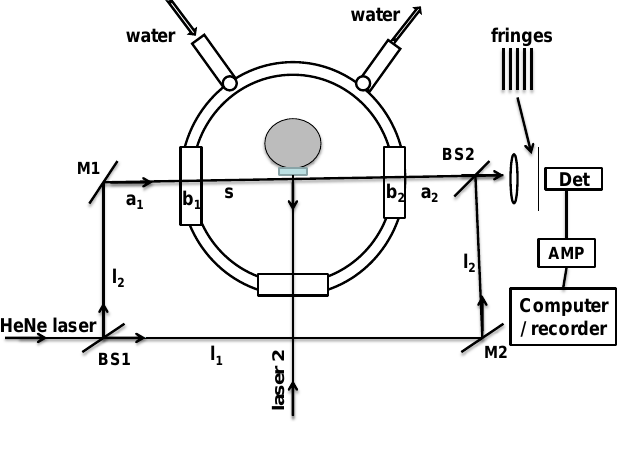
Figure 15. Optical configuration of the Mach-Zehnder interferometer configuration for the measurement of changes in solution concentration/index of refraction. Measurement beam passes in front of the seed crystal inside the solution. Laser 2 is used for growth rate measurement